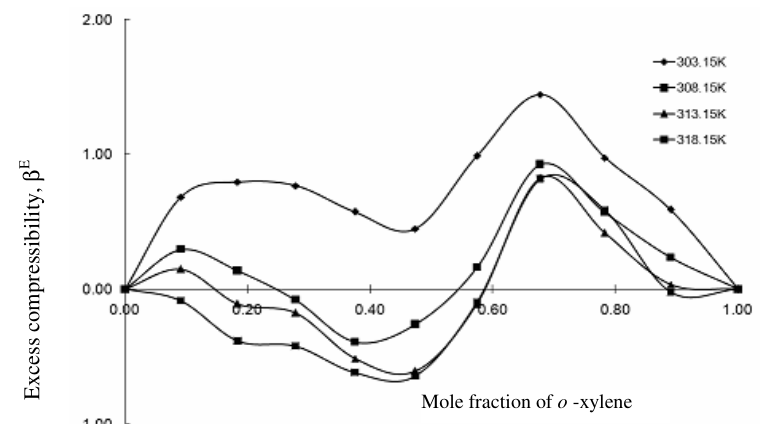
Mole fraction of o -xylene Figure 2. Variation of excess compressibility with mole fraction at different temperatures.